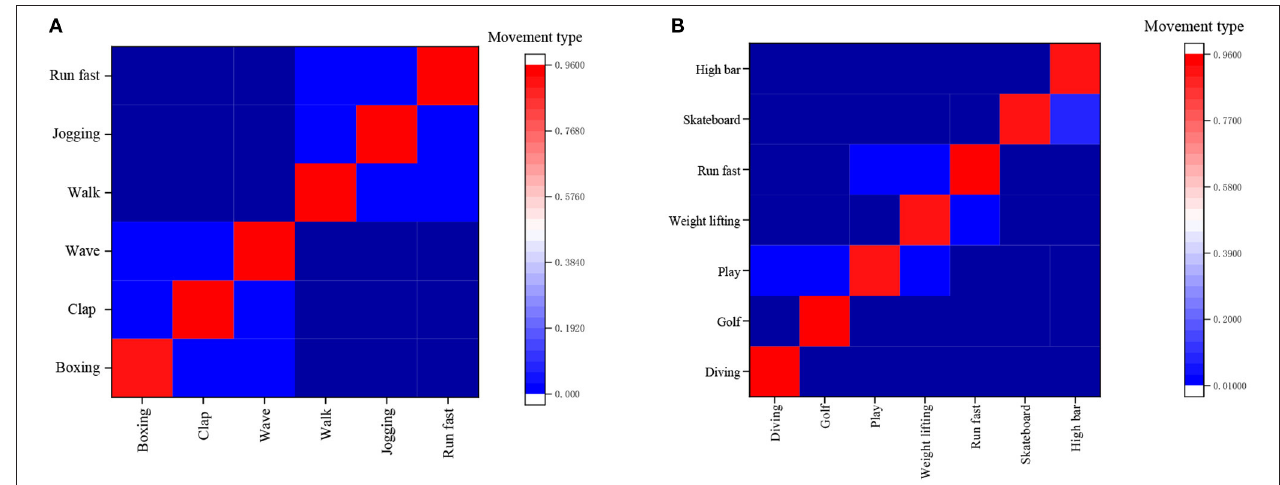
FIGURE 17 | Recognition results of the confusion matrix. (A) Results of KTH confusion matrix, (B) Results of UCF Sports confusion matrix.